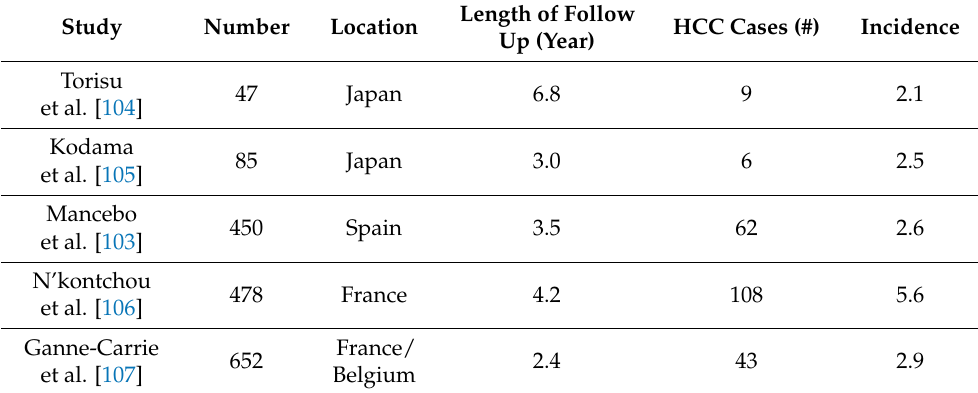
Table 2. The incidence of HCC in alcoholic